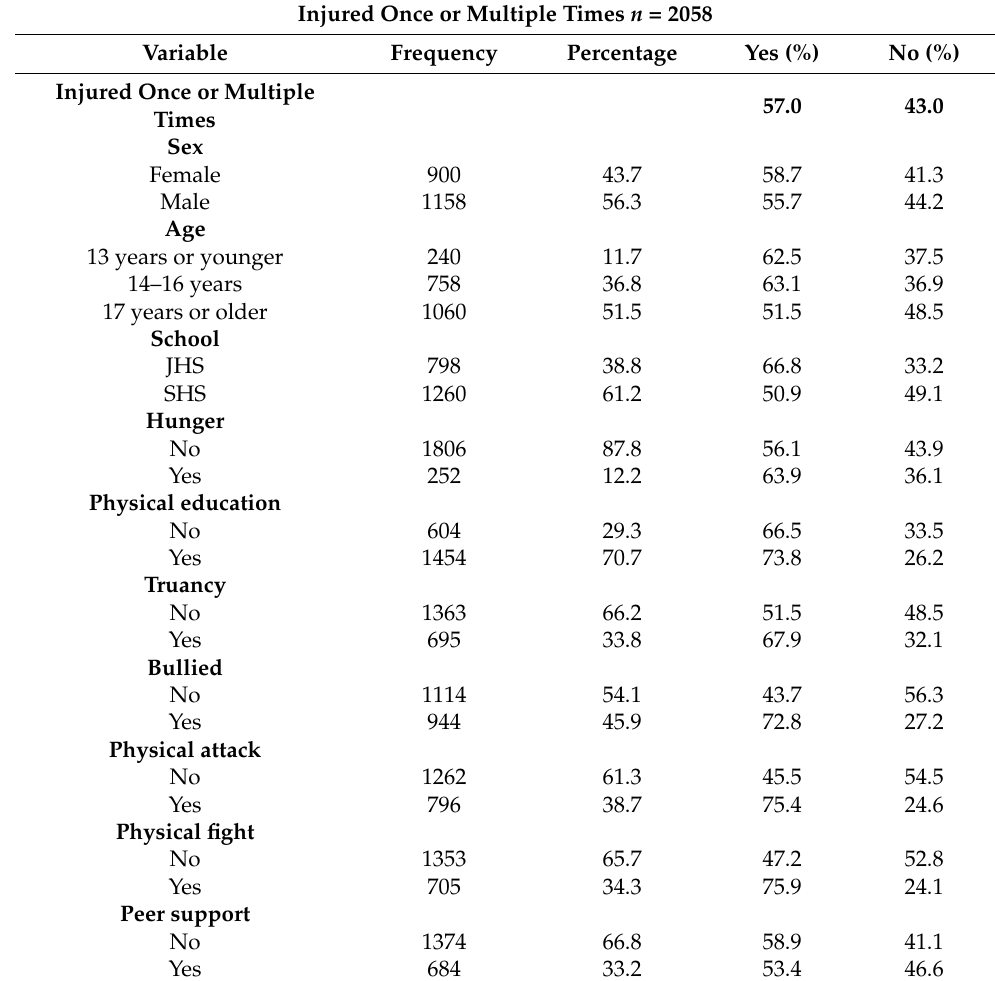
Table 2. Sample background characteristics and prevalence of